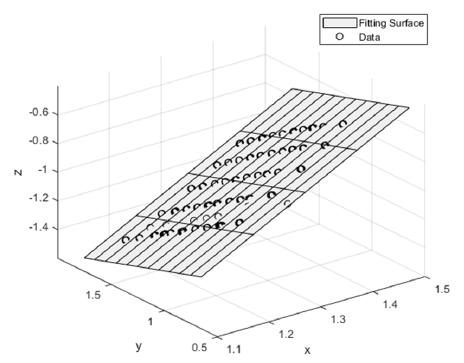
Figure 6. Normal Figure 6. Normal surface.